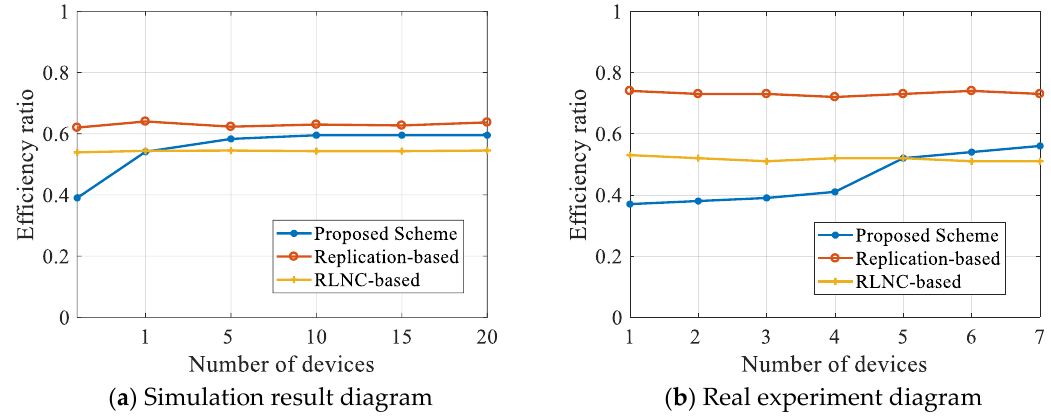
Figure 10. Analysis of utilization.